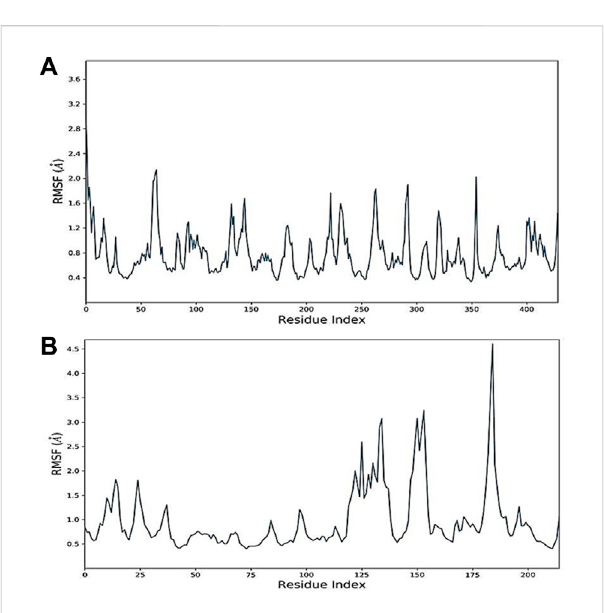
FIGURE 7 Root mean square fl uctuation (RMSF) of docked complexes: (A) Oleanolic acid-MMP9 and (B)